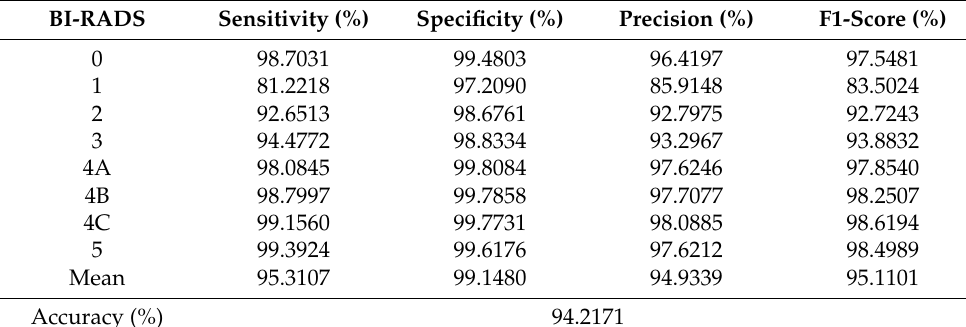
Figure 9. A confusion matrix for performance analysis. Table 6. Performance metrics of the proposed